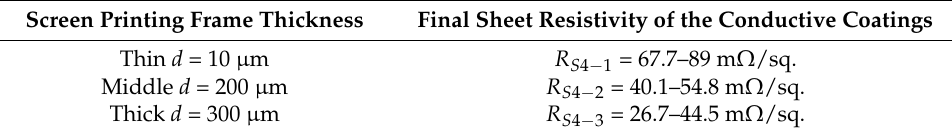
Table 6. Cu/Ag films on CFRP substrate with coated area of 4 cm × 4